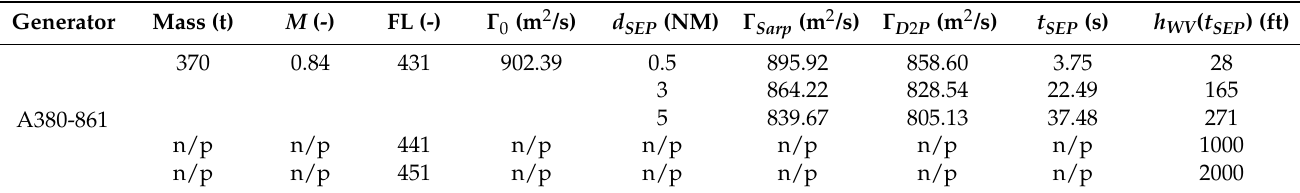
Table A6. Maximum circulations of wake vortex encountered by aircraft behind several generator aircraft in realistic scenarios at the ceiling of A380-861, and flight conditions of the